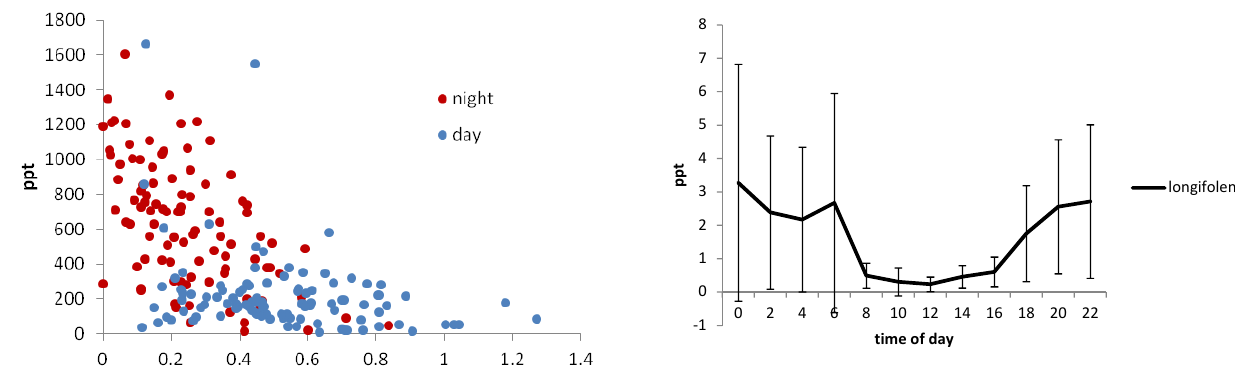
Fig. 10. The mean diurnal variability and standard deviations of longifolene in